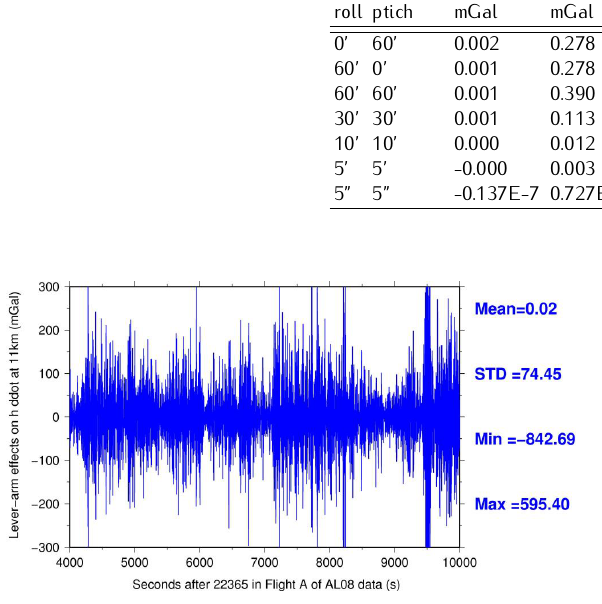
Table 2. Attitude accuracy requirement analysis for lever-arm errors under perfect setup condition. Added Noise Mean